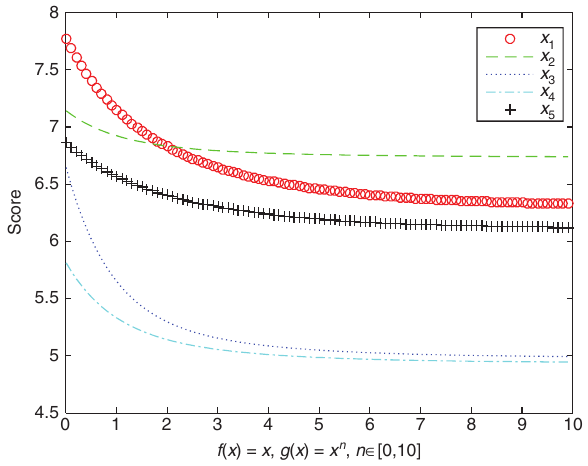
Figure 3: Scores with f ( x ) = x , g ( x ) = x n .